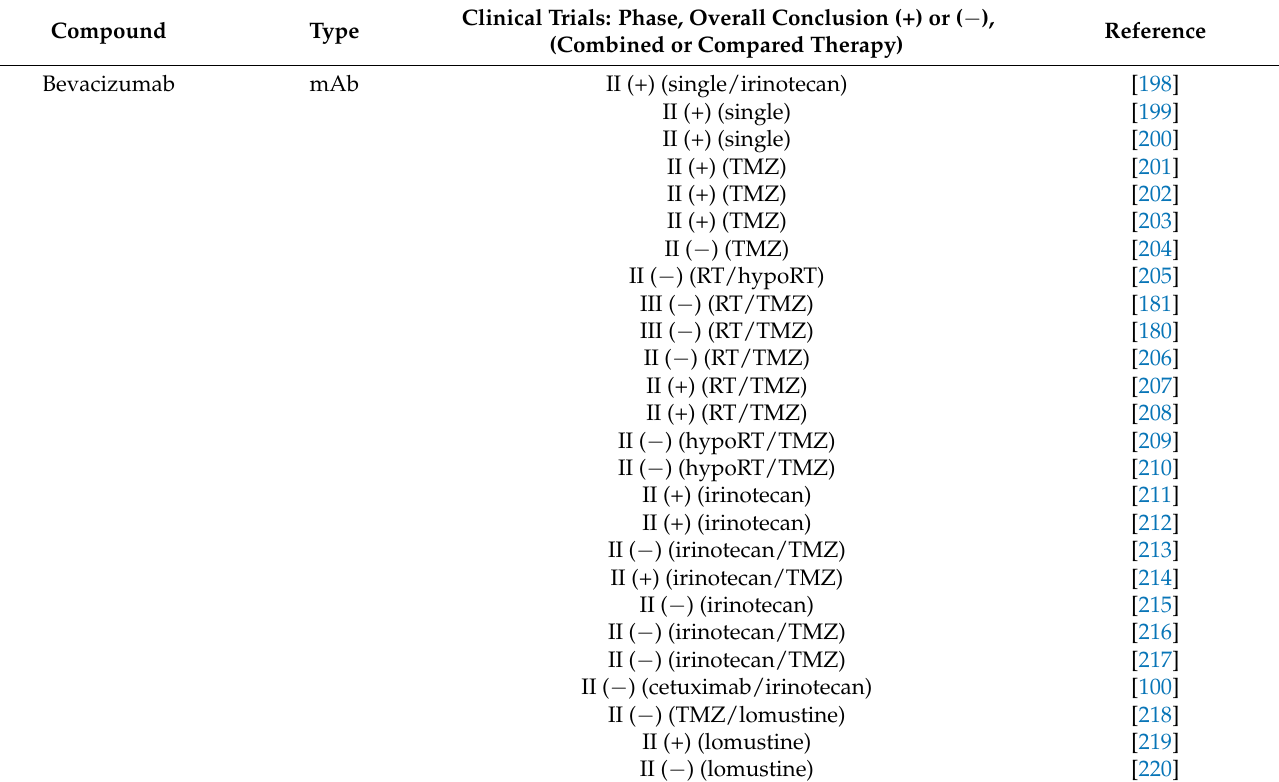
Table 4. Clinical trials in GB targeting the vascular endothelial growth factor receptor.